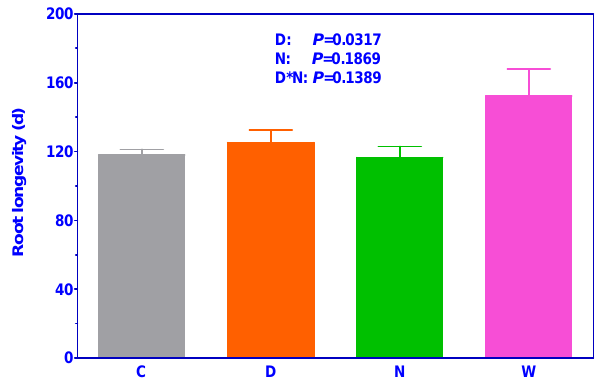
Fig. 3. Root longevity under conditions of control (C), day warm- ing (D), night warming (N), and continuous warming (W) at soil depths of 0–30cm during the growing seasons of 2007–2009. Data shown in the figure were based on a total number of 4442 and 6435 and 4655 and 4475 individual roots for control, day warm- ing, night warming and continuous warming, respectively. Mean lifespan were generated using the Kaplan-Meier method. Data are mean ± SE of six plots.